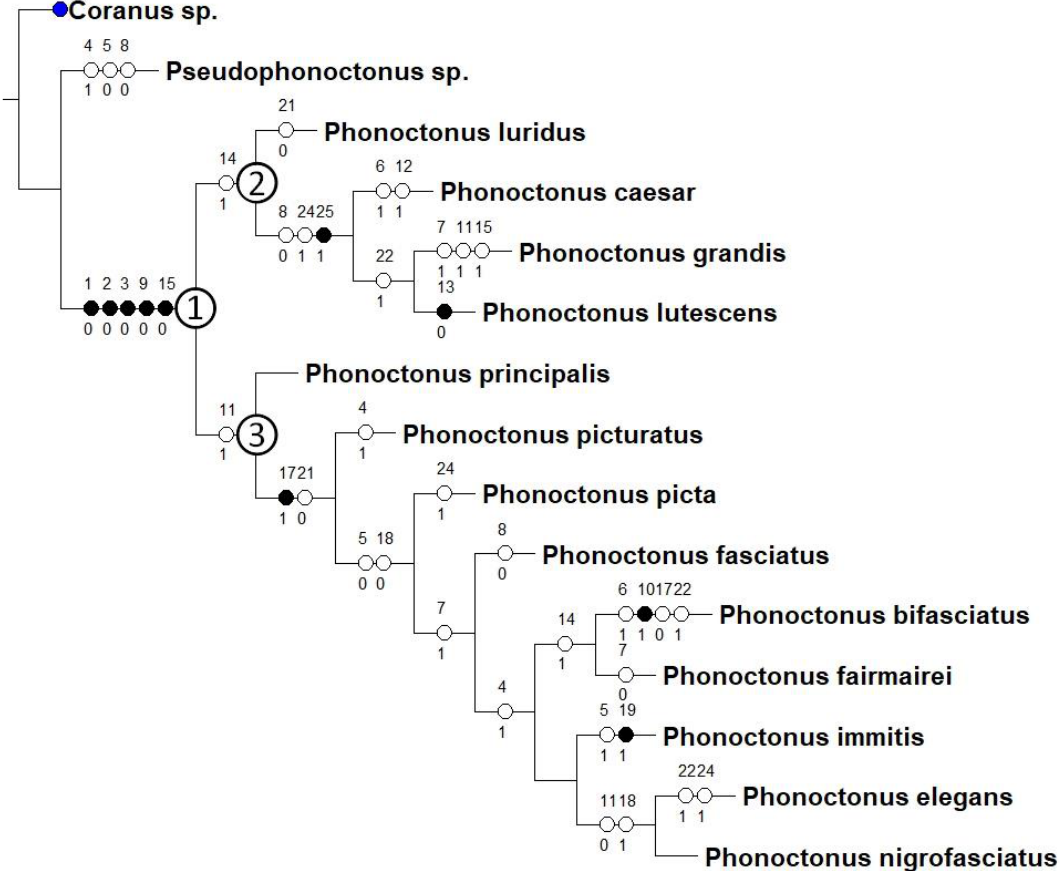
Figure 59. Phylogenetic hypothesis for Phonoctonus species. Most parsimonious tree based on morphological data. Node numbers placed in open circles. Synapomorphies are shown as black circles on branches. Contradicted apomorphies are shown as white circles. Coranus sp. as root of tree.